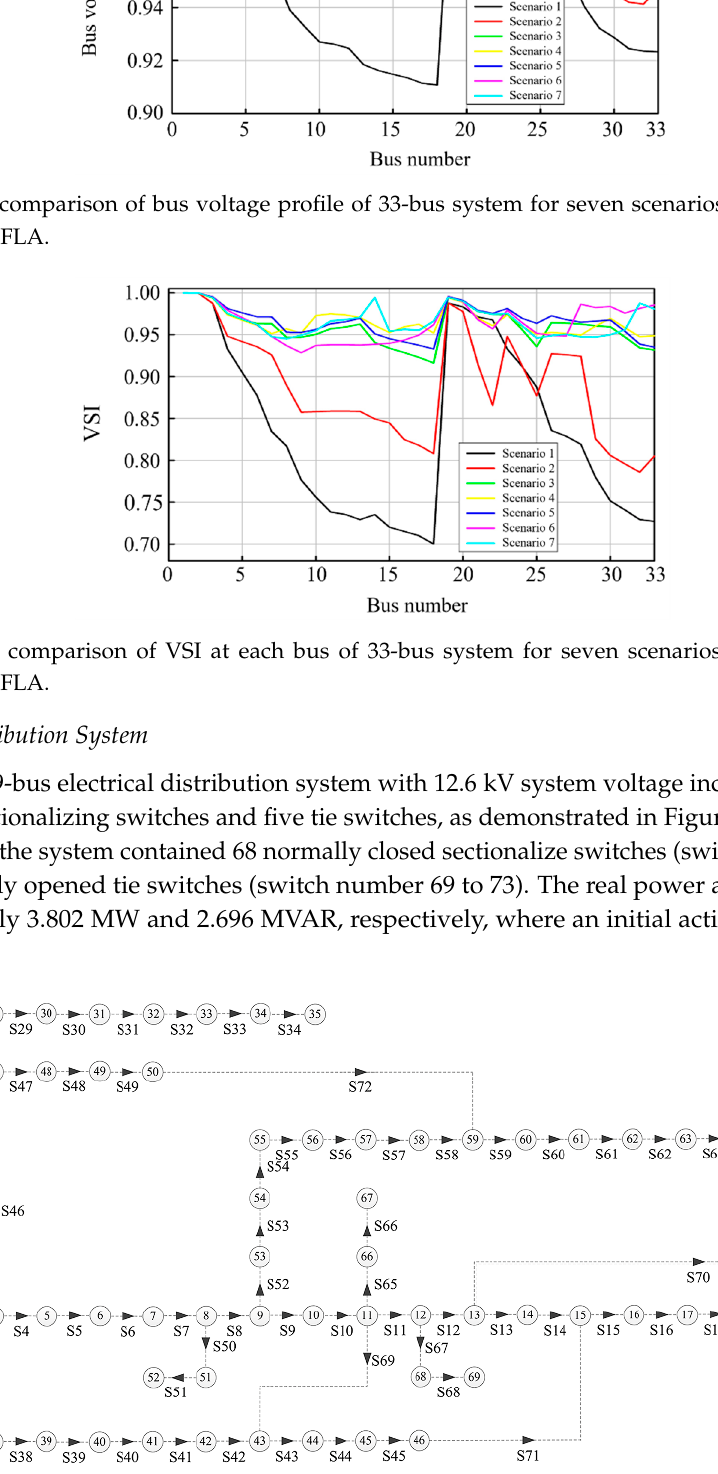
Figure 5. IEEE 69-bus distribution system [14].